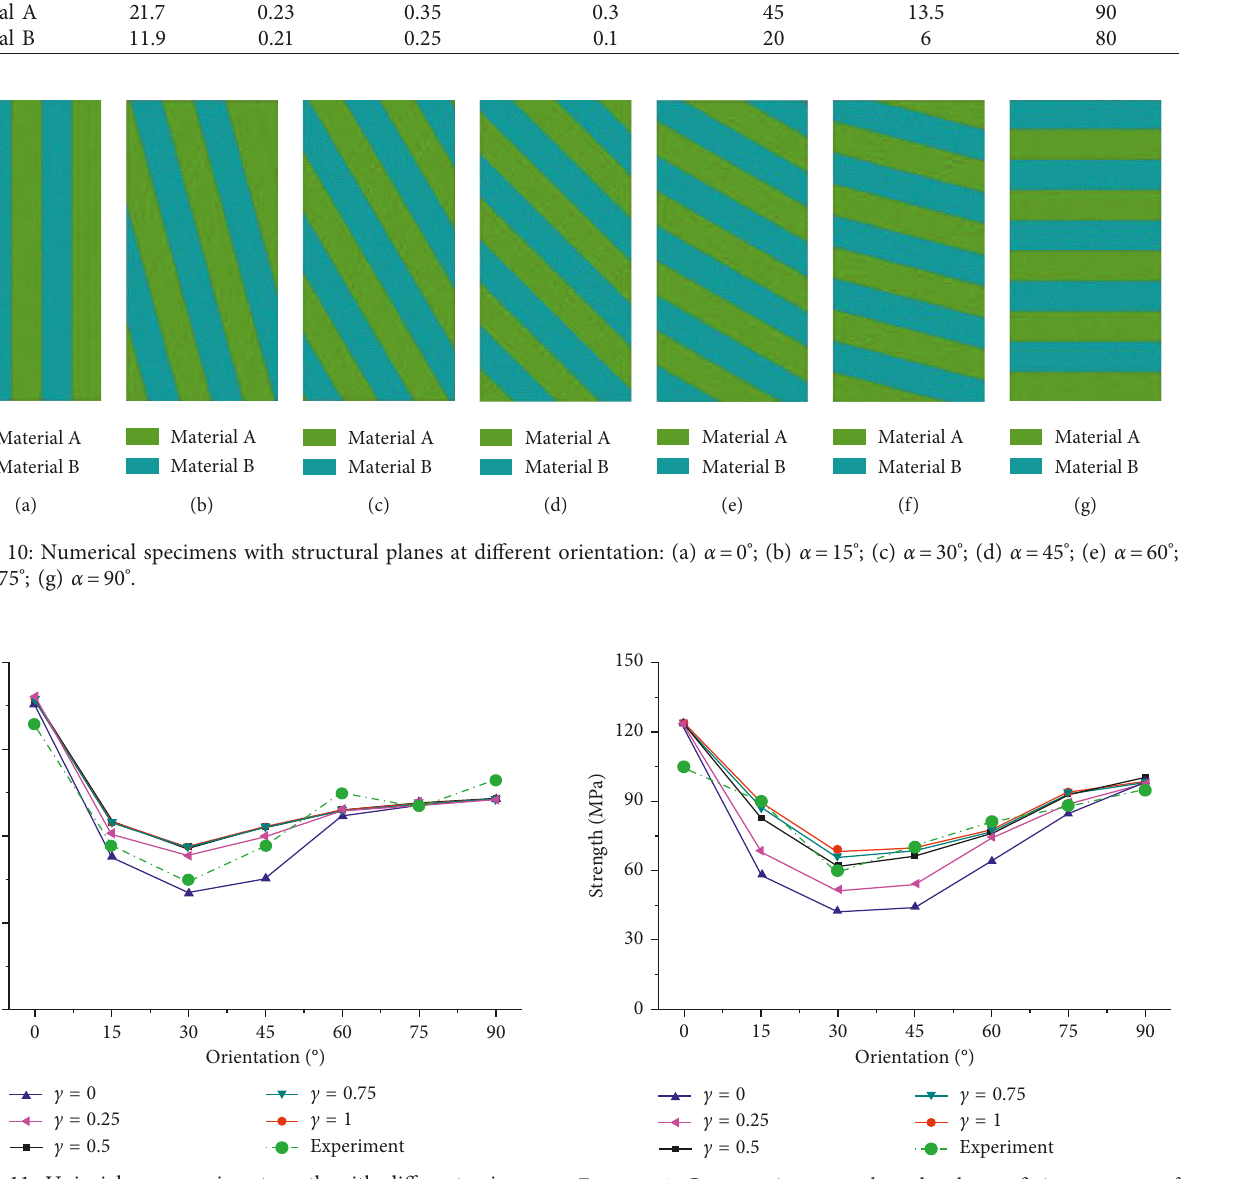
Figure 12: Compressive strength under the confining pressure of 14MPa with different microparameters on material interface.